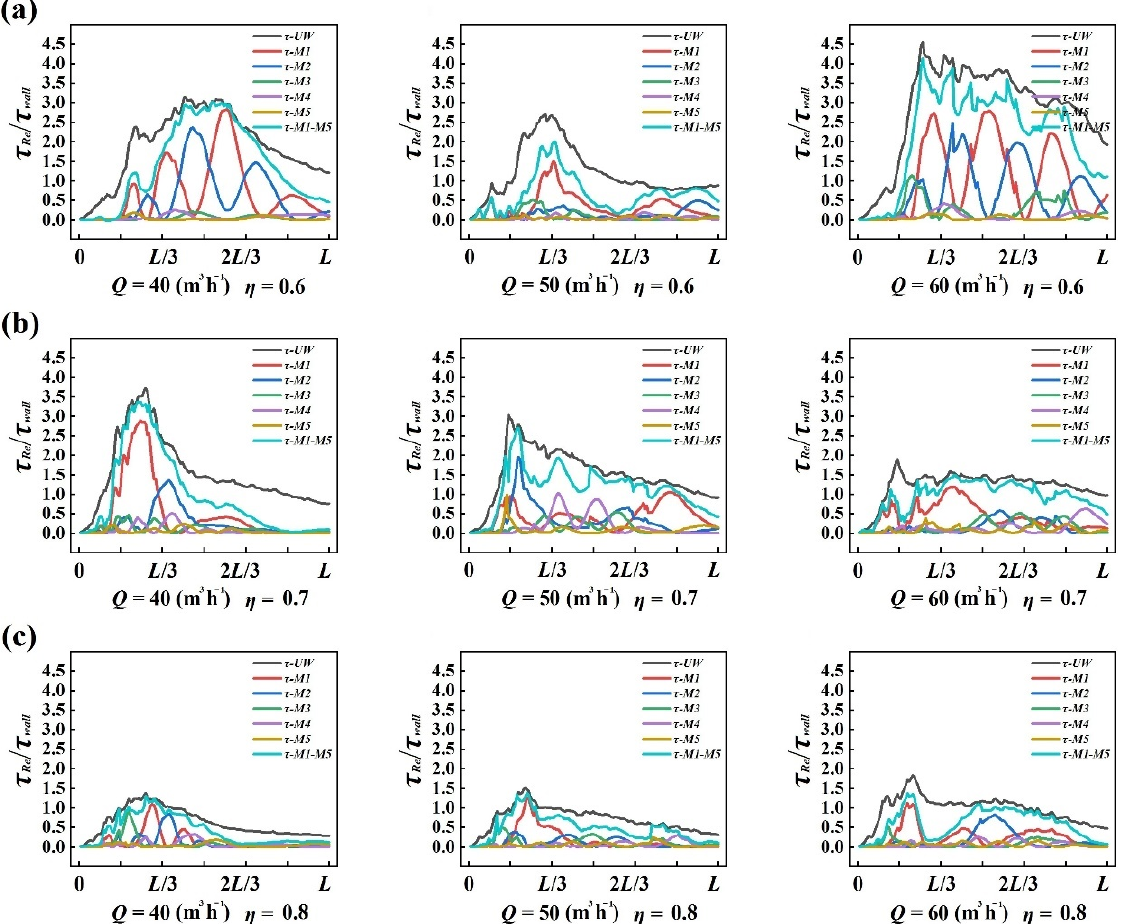
Figure 6. Reynolds stress contribution curves of the first five modes: ( a ) the contribution curves for η = 0.6 at three flows; ( b ) the contribution curves for η = 0.7 at three flows; ( c ) the contribution curves for η = 0.8 at three flows.